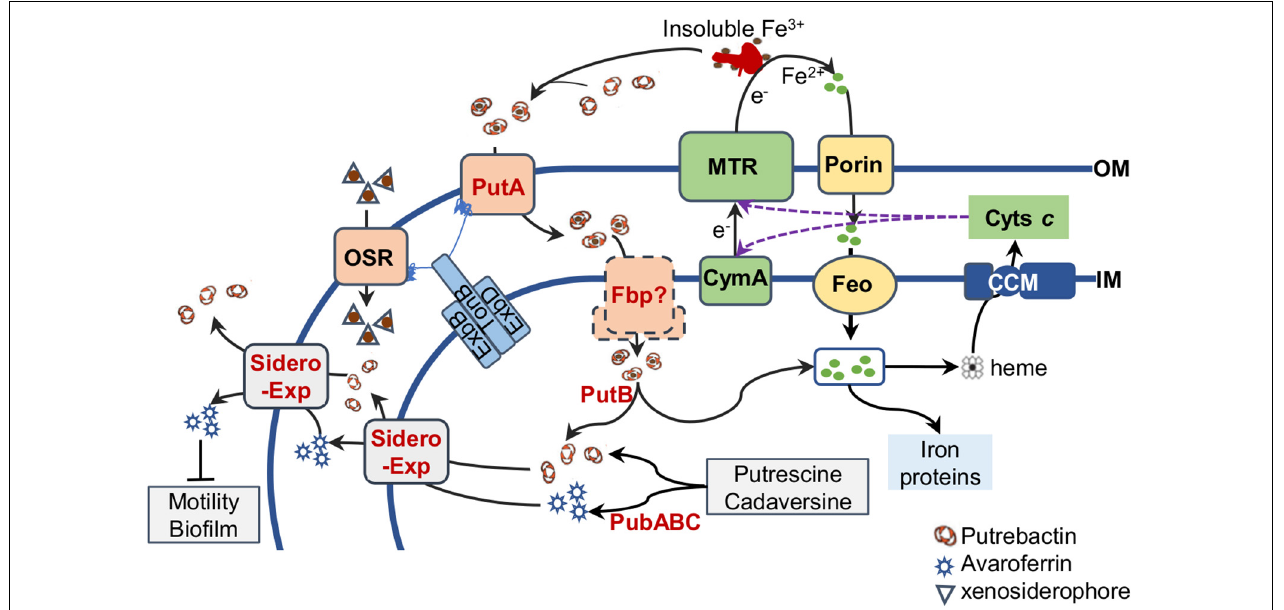
FIGURE 5 | Siderophore biology in S. oneidensis . Siderophores (putrebactin and avaroferrin) are synthesized by PubABC in the cytoplasm and exported by unknown exporters (Sidero Exp) on the IM (inner membrane) and OM (outer membrane). By binding to Fe 3 + of insoluble Fe 3 + compounds, siderophores promote solubility of insoluble Fe 3 + compunds and form ferrisiderophores, which are imported into the periplasm by TBDR PutA and then probably transported across the IM by Fbp ATP transporter. Ferrisiderophores are reduced by FSR PutB, resulting in Fe 2 + release. Fe 2 + can also be imported into the cell through porins on the OM and FeoAB system on the IM. The intracellular Fe 2 + pool is maintained in balance to ensure biosynthesis of iron proteins and heme, which is the cofactor for cytochromes c synthesized by the cytochrome c maturation (CCM) system on the IM. Matured cytochromes c , including CymA and the metal reducing (MTR) system that convert Fe 3 + to Fe 2 + extracellularly with electrons from the quinol pool in the IM (not shown), confer S. oneidensis cells respiratory versatility. OSR, other siderophore receptor, important for import of iron-xenosiderophores released by other bacteria. Avaroferrin has additional activity affecting motility and biofilm.